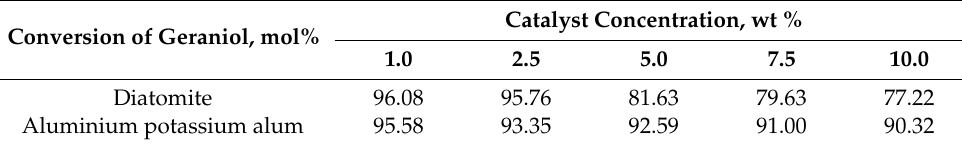
Table 5. The influence of the catalyst concentration on the GA conversion. Conversion of Geraniol,